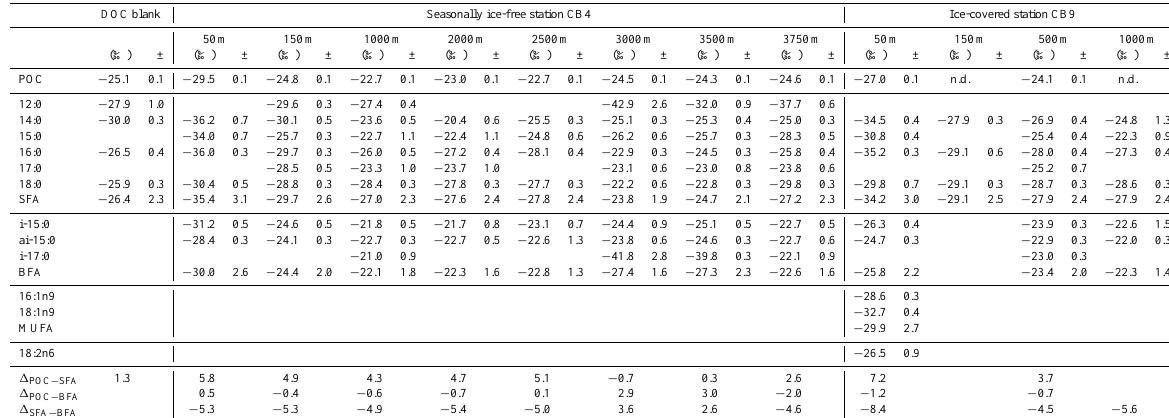
Table 2. Blank-corrected δ 13 C values of POC and FAMEs in the Canada